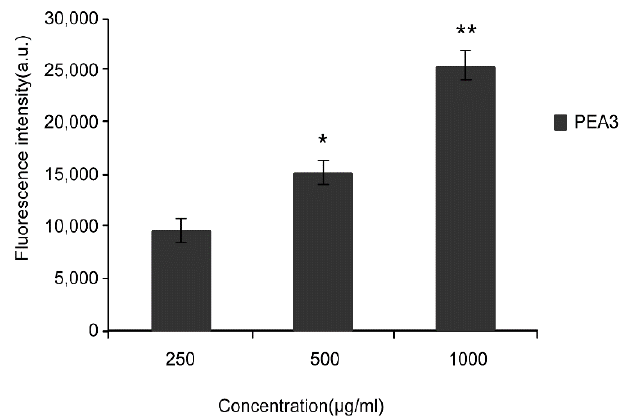
Figure 4. Fluorescence intensity of PEA3-NPs by Caco-2 cells at various concentrations for 4 h. Note: * P < 0.05, ** P < 0.01 significant difference compared with control groups (250 μg/m L).